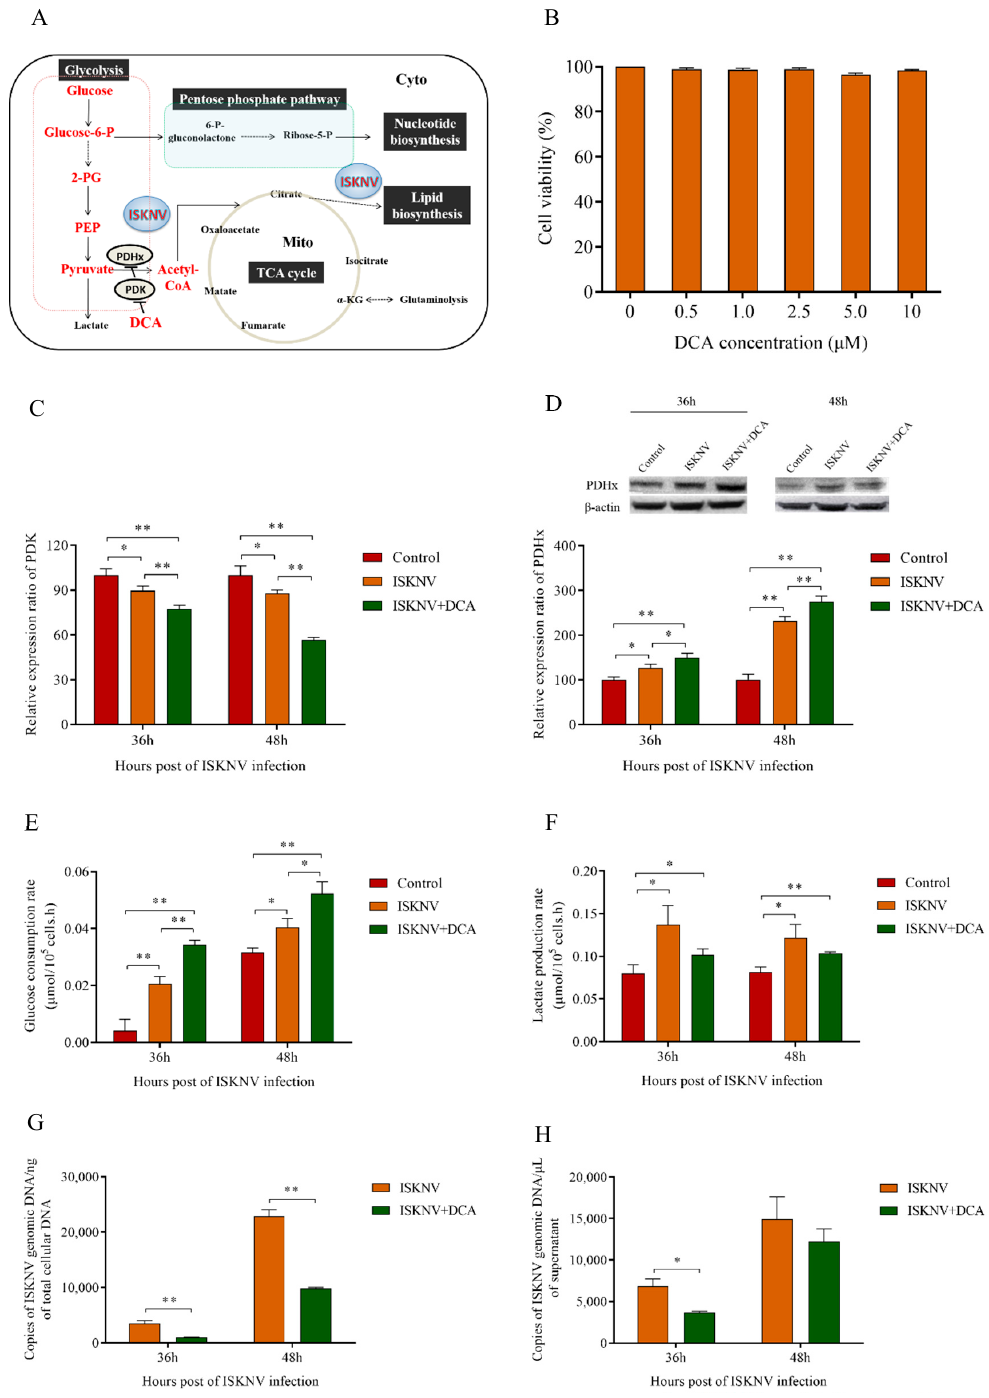
Figure 6. The tricarboxylic acid ( TCA) cycle was not necessary for ISKNV multiplication. ( A ) Overview of cellular metabolism with glucose. DCA inhibited the expression of PDK to promote the expression of PDH, which promoted pyruvate into the TCA cycle. ( B ) CPB cells were cultured in a complete medium treated with 0–10 μ M of DCA, and the cell viability was detected by MTS assay at 72 hpi. ( C ) Real-time quantitation of PDK expression in CPB cells. ( D ) Western blot analysis of PDHx expression in CPB cells. ( E , F ) The glucose consumption and lactate production in ISKNV infected CPB cells. ( G , H ) CPB cells treated with DCA, or without DCA were infected with ISKNV. Viral yield in cells and in supernatant was determined by real-time PCR. * p < 0.05; ** p <